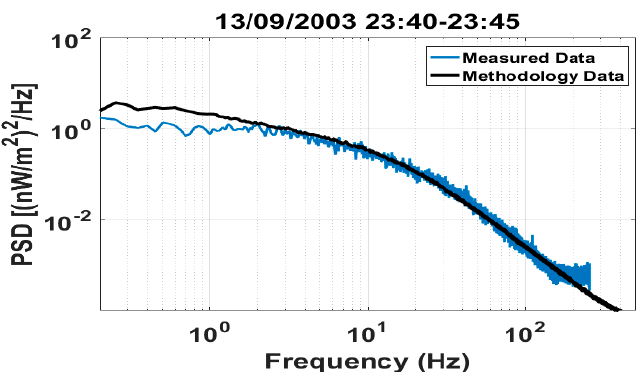
Figure 5. Second order irradiance statistics validation for session on 13/09/2003 23:30. PSD of measured data vs. PSD of generated data.